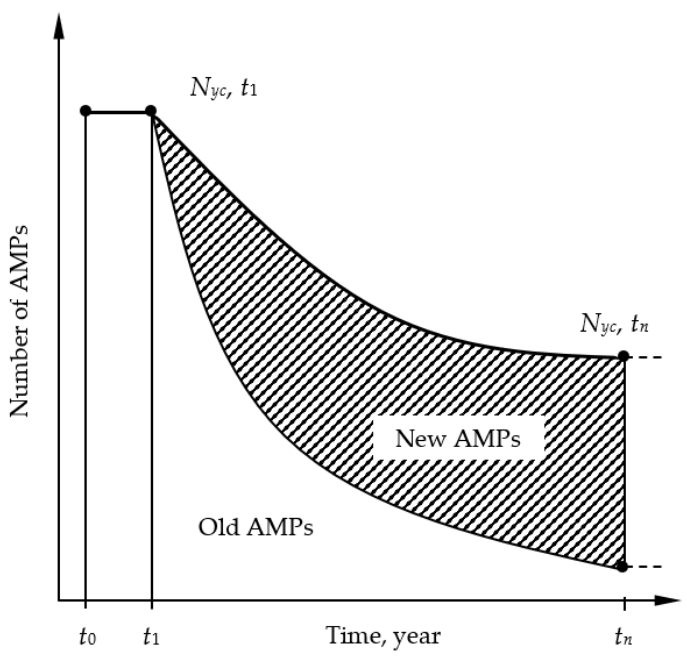
Figure 7. The model of the dynamics of renovating the AMPs’ fleet in the Baltic States .